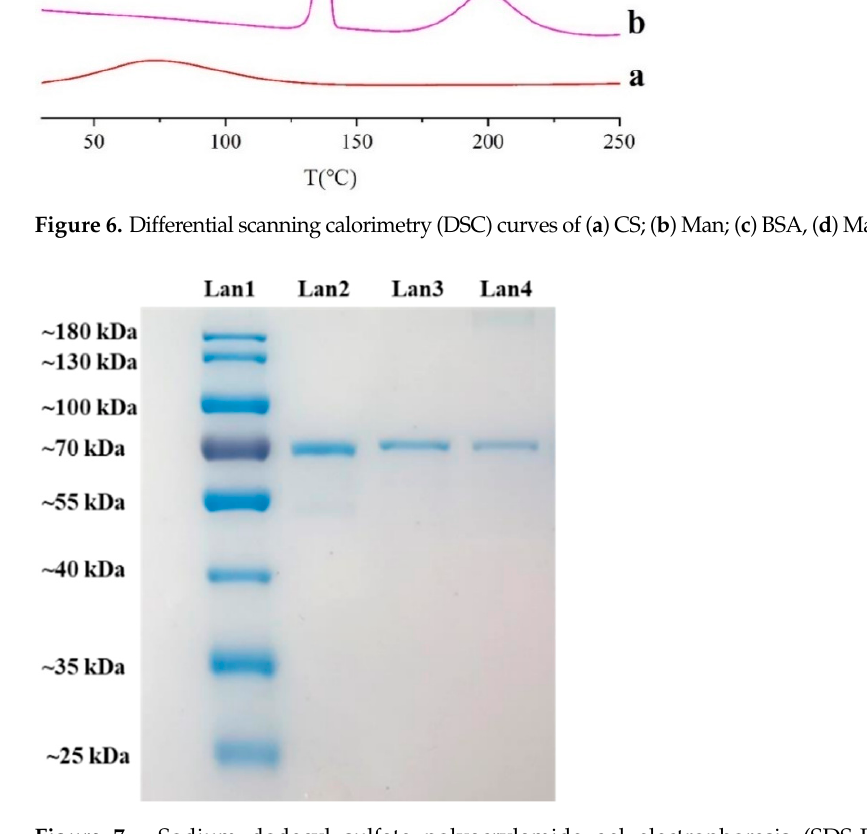
Figure 6. Differential scanning calorimetry (DSC) curves of ( a ) CS; ( b ) Man; ( c ) BSA, ( d ) Man-BSA- CS-NPs.